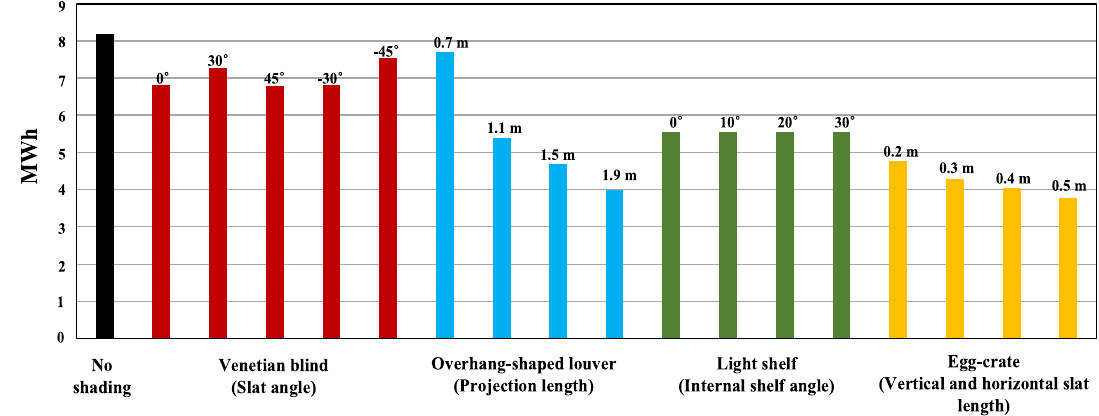
Figure 9. The reduction of annual cooling energy consumption by shading devices.